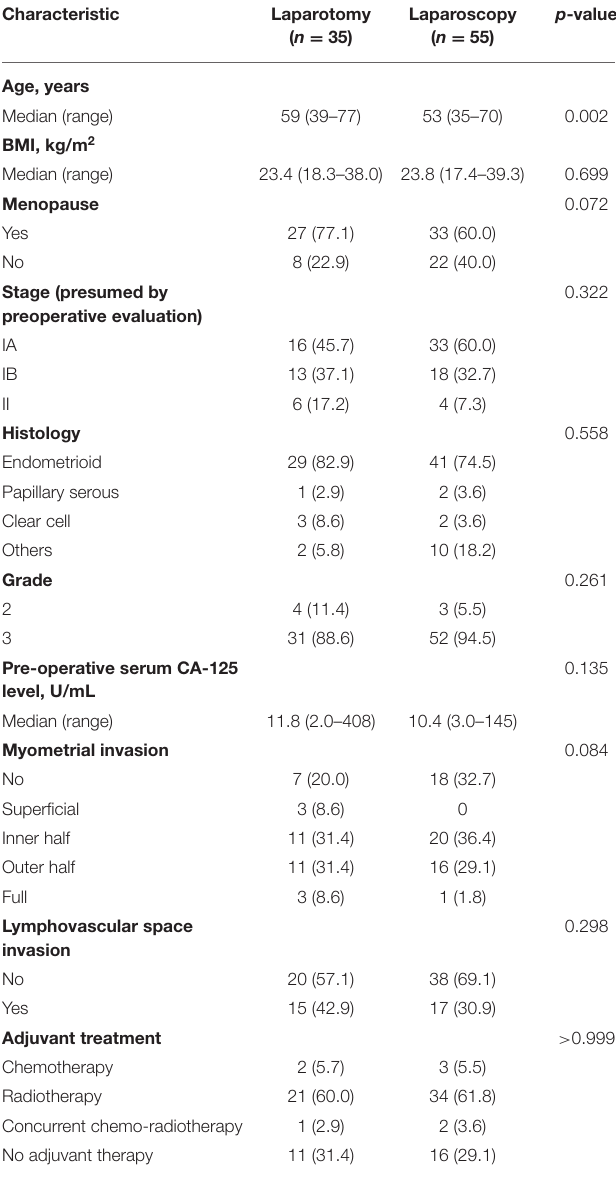
TABLE 1 | Baseline demographics and clinicopathologic characteristics of endometrial cancer patients by surgical technique ( n = 90). Characteristic